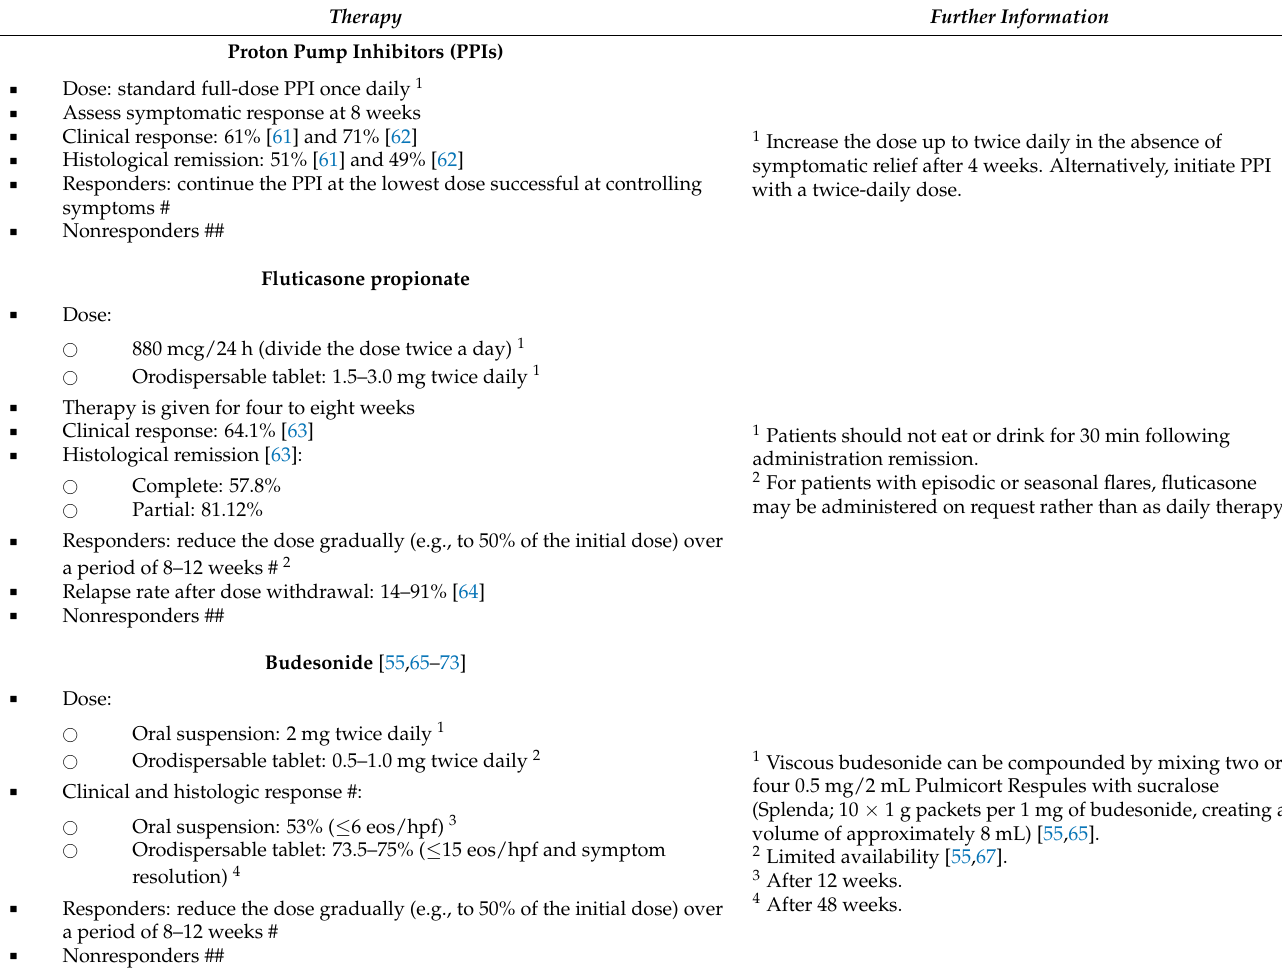
Table 3. Pharmacological management of EoE (first-line treatments in adults). Therapy Further Information Proton Pump Inhibitors